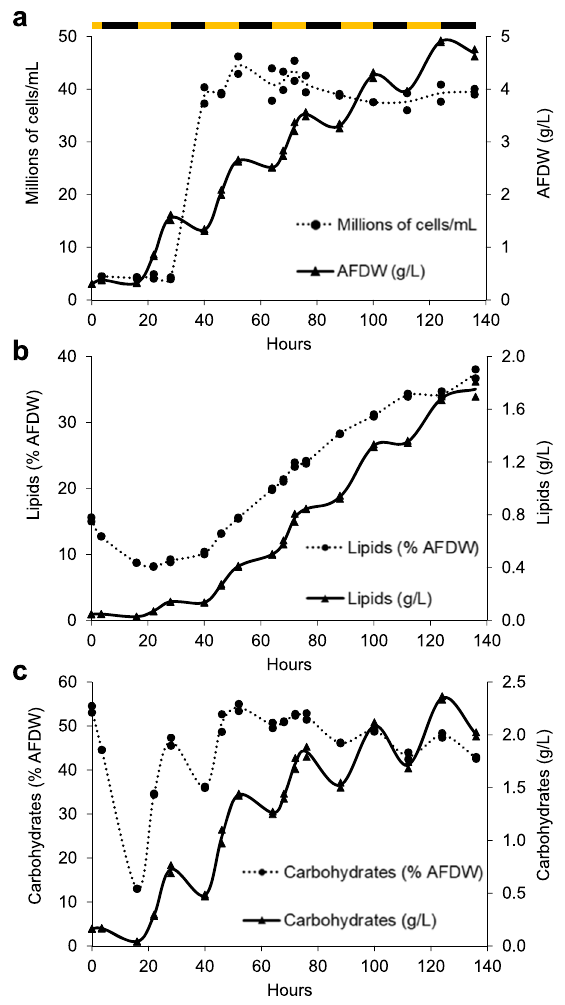
Fig. 2 Growth and compositional analysis of Scenedesmus sp. NREL 46B- D3. a Growth curves in terms of ash free dry weight (AFDW) and cells per milliliter. b Growth curves in terms of lipids as fatty acid methyl esters (g/L) and lipids (% AFDW). c Growth curves in terms of carbohydrates (g/L) and carbohydrates (% AFDW). Data points represent the average and standard deviation of n = 2 biological replicates. Alternating black and yellow bar represents the lighting cycle (yellow = light cycle, black =